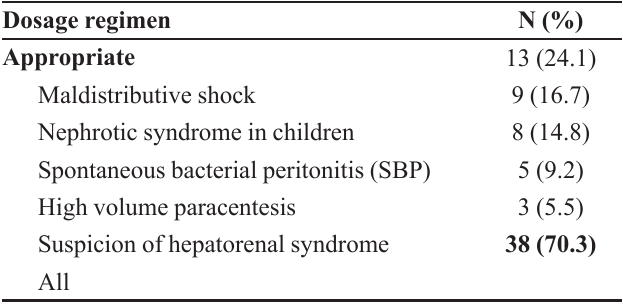
TABLE VIII - Analysis of dosage regimens suitability, according to other clinical protocols (HU-USP, from January to October 2017)